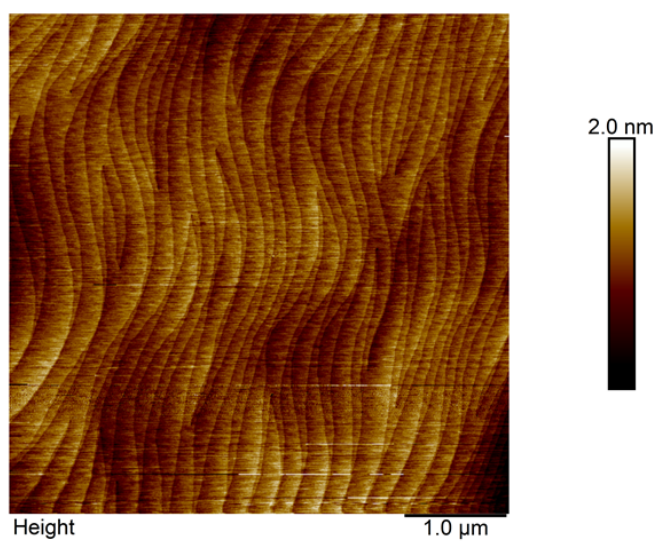
Figure 4. AFM analysis of a 5 × 5 µm scanning area for a 2 µm-thick GaN epitaxial layer on top of a sapphire substrate.